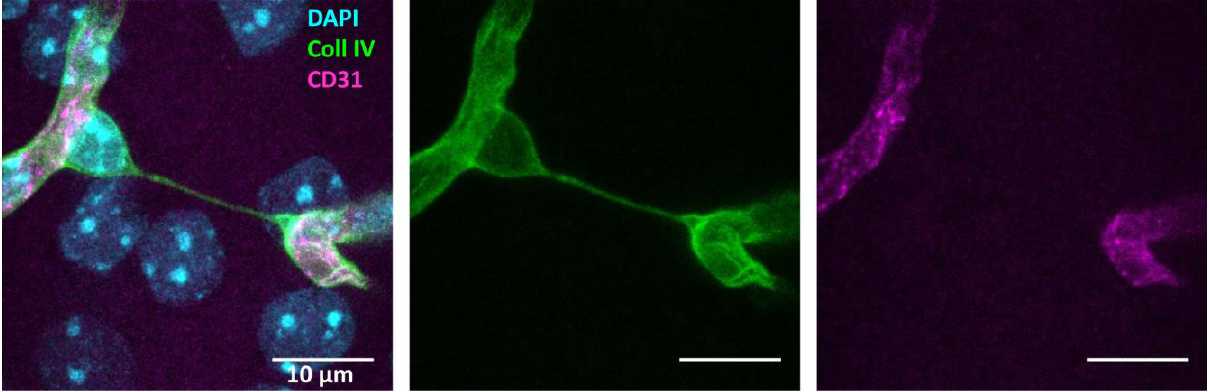
FIGURE 1: Example of a string-vessel in the mouse cortex. The vessels are labeled with the basement membrane marker Collagen IV (Coll IV, green) and CD31 (magenta). String-vessels are positive for collagen IV, but not CD31. Image achieved by confocal microscopy of a 100 µm thick brain slice. Scale bar = 10